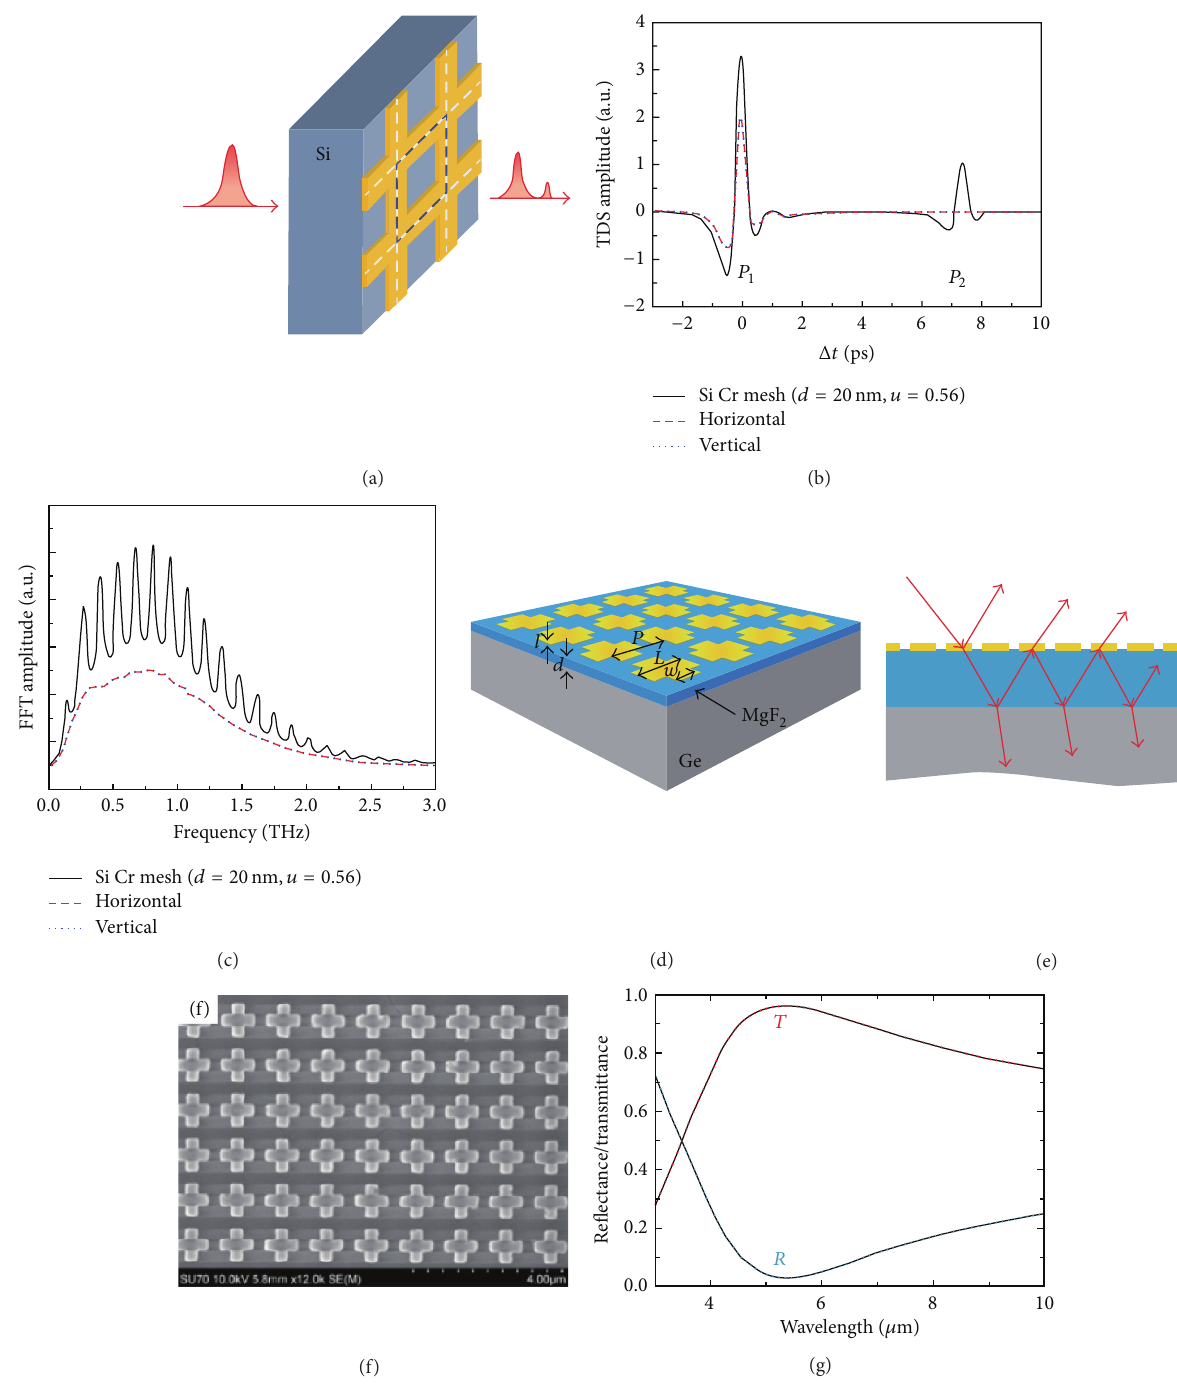
Figure 14: (a) A schematic of the THz measurement with THz wave normal incident from the left side of Si substrate and square mesh AR coating on the right side of Si substrate. (b) THz TDS transmission signals under normal incidence. The solid curve is for bare Si and the dashed and dotted curves are for AR-coated Si in horizontal polarization and vertical polarization, respectively. (c) FFT of the THz TDS spectra. (d) Schematic of the metasurface antireflection coating on a germanium substrate, consisting of a periodic array of gold cross- resonators on top of a dielectric layer. (e) Schematic of multireflection within the metasurface antireflection structure. (f) The SEM image of a fabricated metasurface antireflection structure. (g) Calculated optical reflectance ( 𝑅 ) and transmittance ( 𝑇 ) using full-wave numerical simulation. Figures are reproduced from (a)–(c) [41] and (d)–(g)